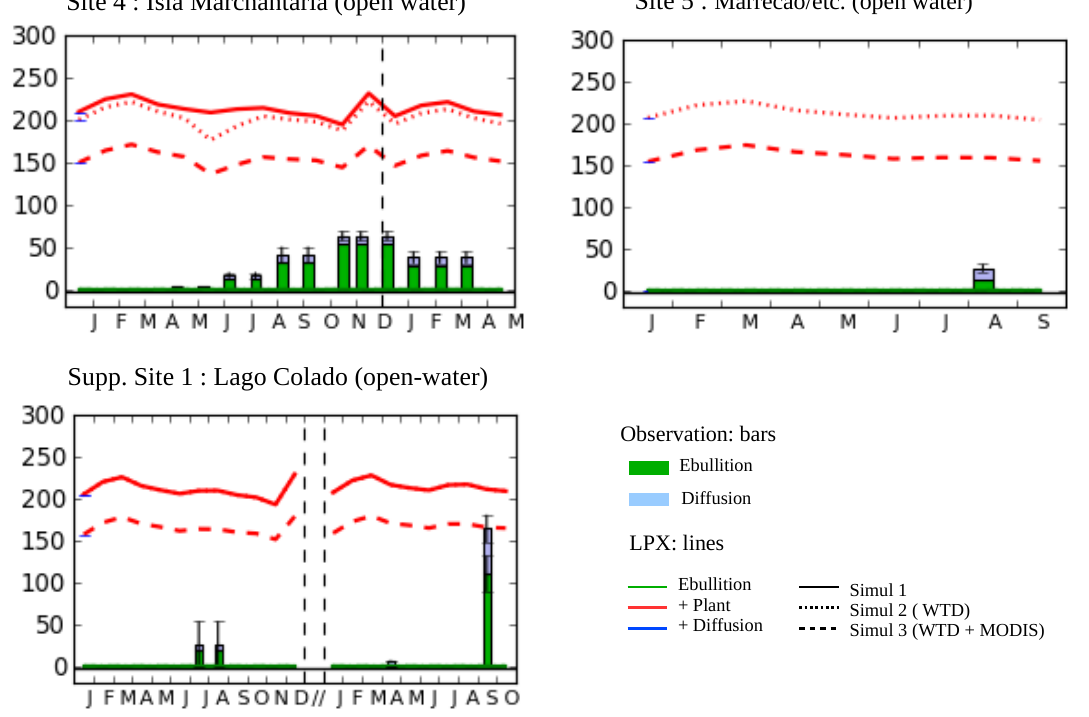
Fig. A8. Comparison between LPX-simulated CH 4 flux densities and open-water measurements for sites 4 and 5 and Supp. Site 1. Plotted LPX simulations correspond to simulations 1–3 (cf. Table